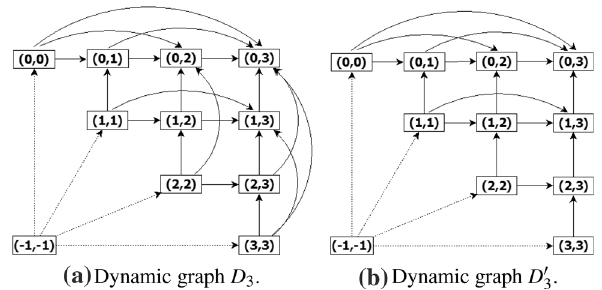
Fig. 5 Dynamic graphs D 3 and D ′ 3 for a set of n = 3